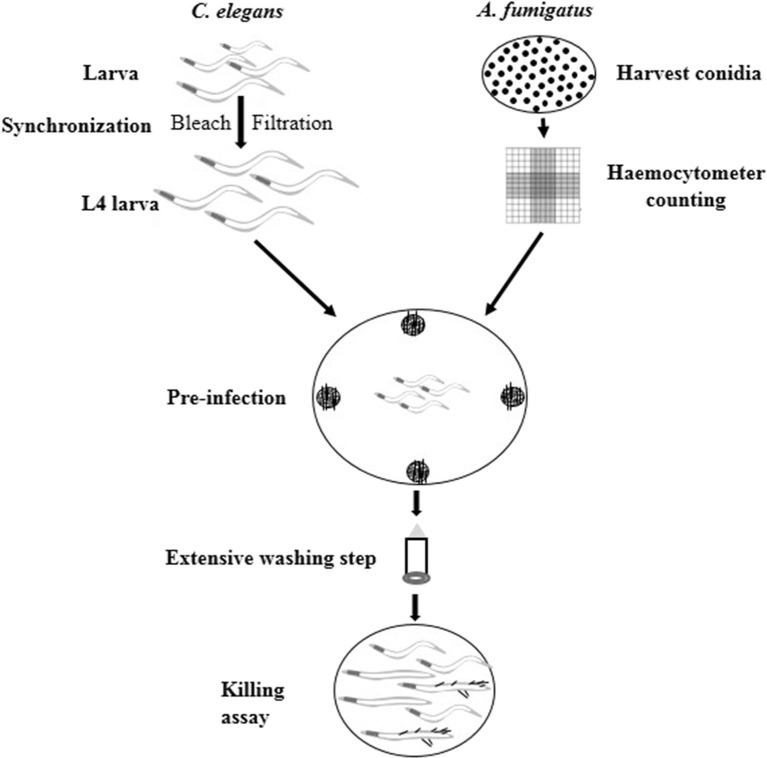
Schematic procedure of C. elegans-based A. fumigatus infection model. Synchronized L4 stage worms were put into NGM plates containing A. fumigatus spores at the four edges for 16 h pre-infection. Then extensive washing step was applied to remove conidia that were not ingested by worms. Finally the washed worms were added to BHI medium for killing assay.